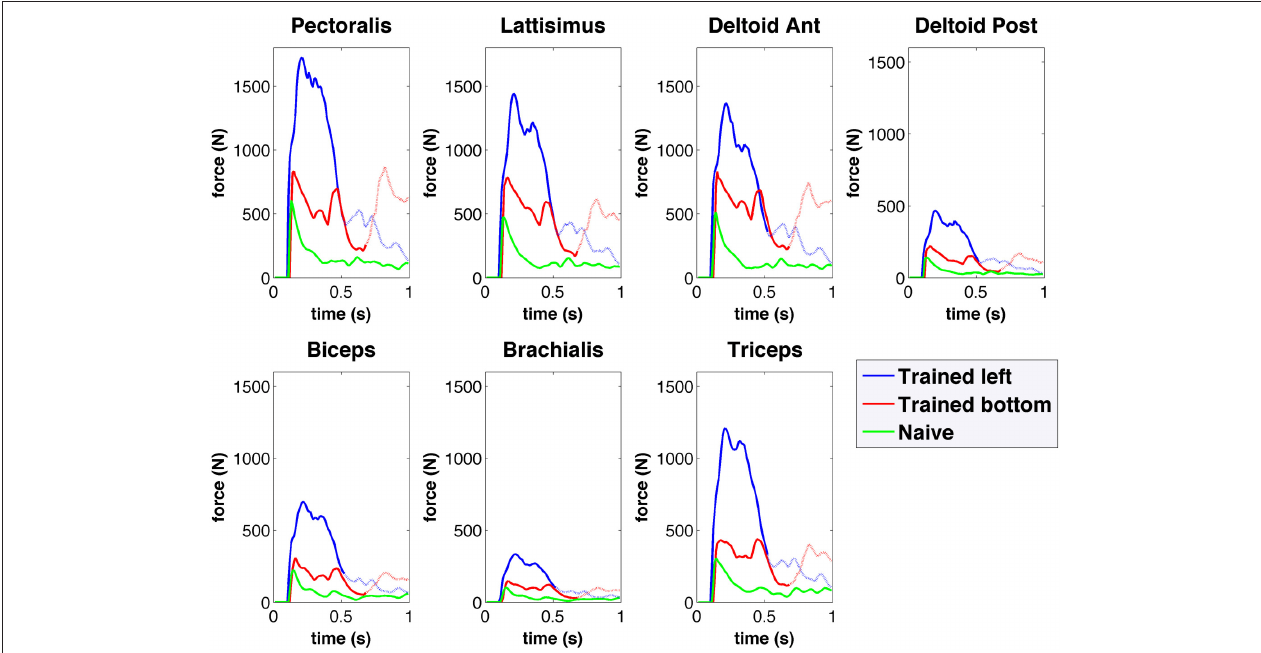
FIGURE 8 | Forces obtained from the spiking network driven virtual arm muscles during center-out reaching to left (blue) and bottom (red) targets for the trained network, and for the naive network (green). Forces are shown for seven of the main muscles involved in reaching. The trained network muscle forces are higher than those of the naive network, and show differentiated activation for each